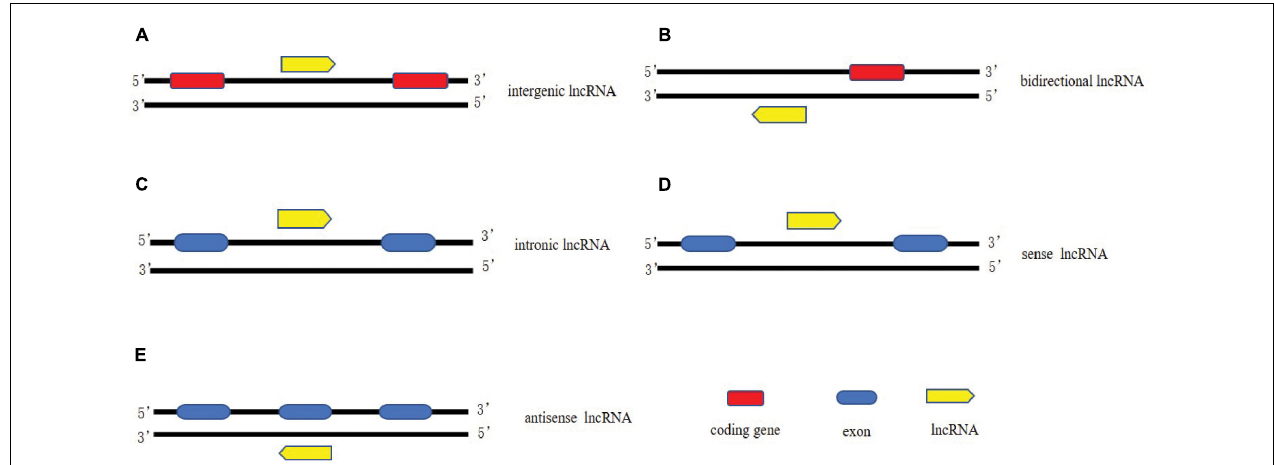
FIGURE 1 | Classification of lncRNAs. (A) long intergenic non-coding RNAs, consisting of independent transcriptional units located between but not overlapped with protein codes; (B) bidirectional lncRNAs transcribed from different bidirectional promoters. (C) intron lncRNAs located in the intron region of protein coding genes (sense or antisense); (D) Sense lncRNAs are transcribed by the sense chain of the protein-coding gene, which overlaps with at least one exon of the protein-coding gene on the same chain and has the same transcriptional direction; (E) Antisense lncRNAs are transcribed by a complementary DNA chain of protein-encoded genes, they are transcribed in the opposite direction and overlaps with at least one exon of the positive gene.